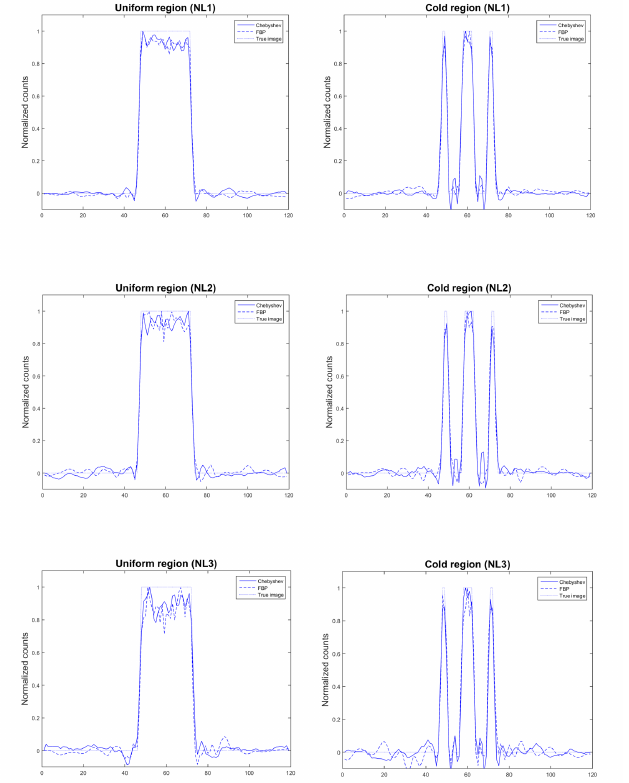
Figure 3. Line profiles of the IQ phantom, in its uniform ( left ) and cold ( right ) regions, for all noise levels.